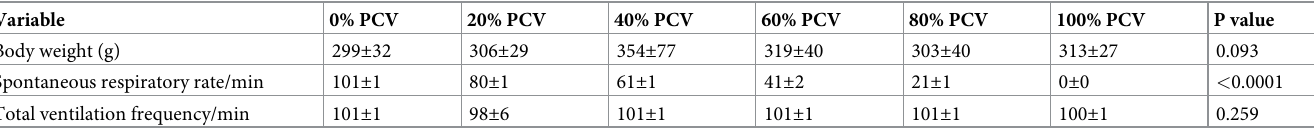
Table 1. Baseline data of the animals.